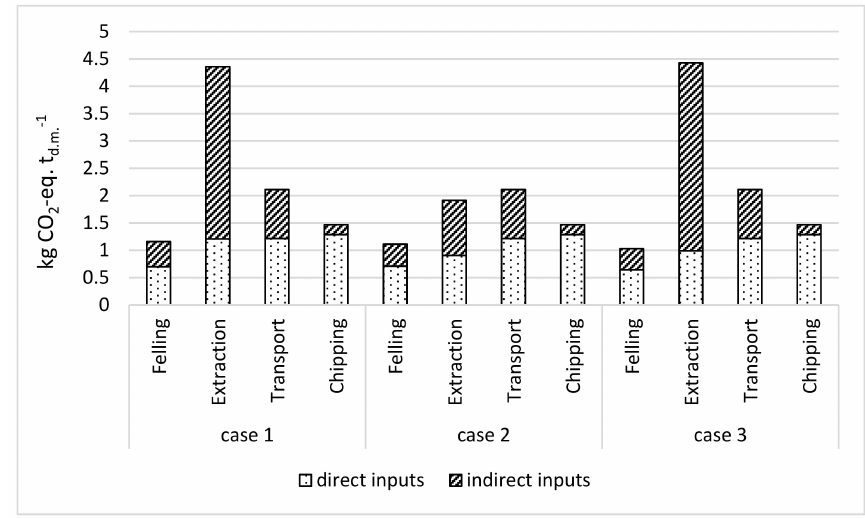
Figure 4. Resulting environmental impacts per process and case in the category global warming potential, distributed with regard to direct and indirect inputs, in kg CO 2 -eq. t d.m. − 1